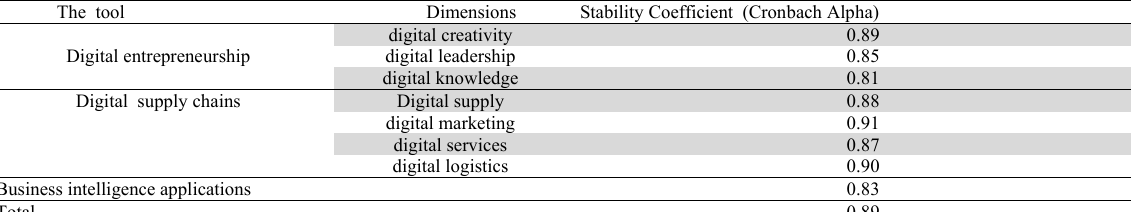
The coefficient of internal consistency for each of the study variables in all its dimensions The